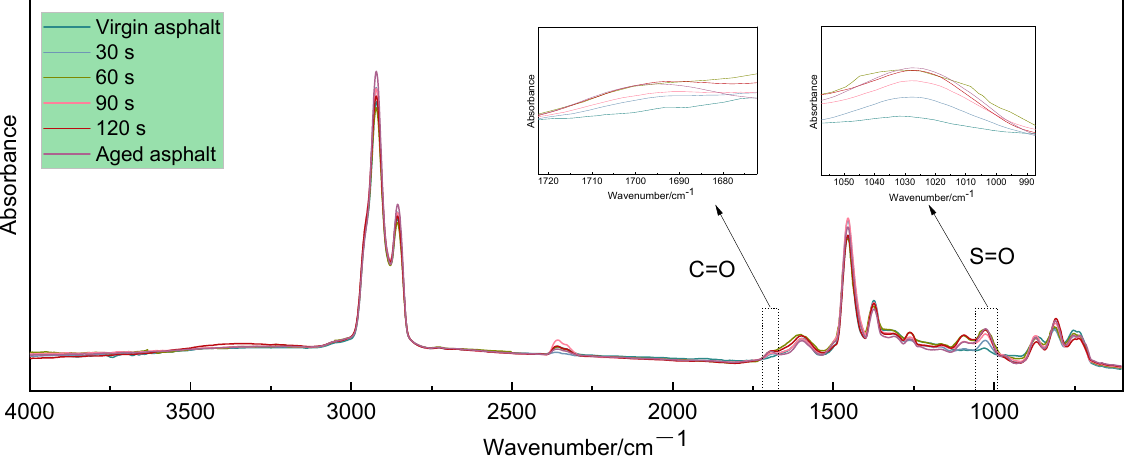
Figure 10. Variation in asphalt creep rate m with different mixing durations at different tempera- tures.